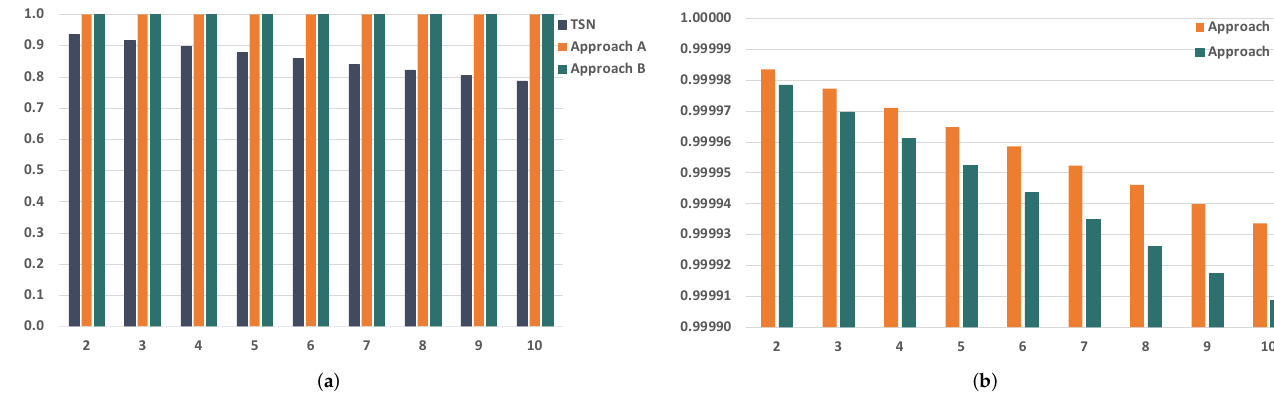
Figure 15. Reliability achievable when varying the number of bridges in a network with a BER of 1 × 10 − 10 . TSN is represented in grey, approach A in orange and approach B in green. The x axis represents the number of bridges, while the y axis represents the reliability. ( a ) Reliability achievable by TSN, approach A and approach B when varying the number of bridges. ( b ) Zoom in the reliability achievable by approach A and approach B when varying the number of bridges.